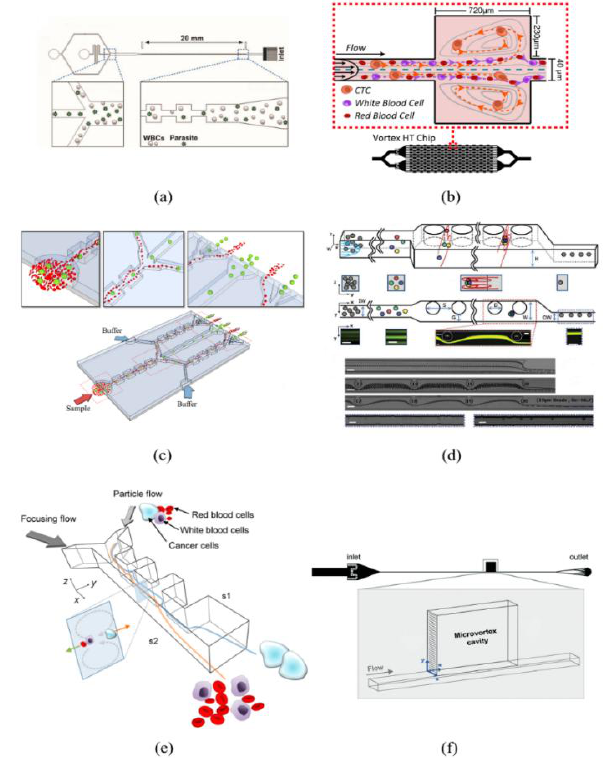
Figure 7. Applications of contraction-expansion-array-channel inertial microfluidics. ( a ) Enriching malaria parasites from blood to facilitate a more reliable and specific PCR-based malaria